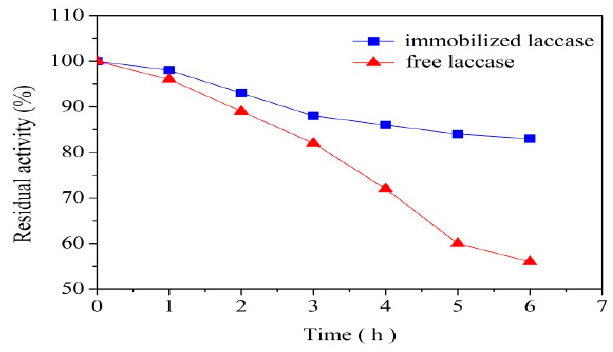
Figure 7. Thermal and operational stability of laccase immobilized on MCCBs by absorption at pH 4.0, 16 g/L initial lacasse concentration and 3 h contact time.